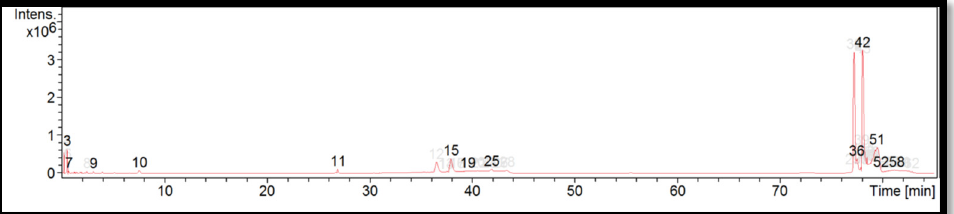
Figure 3. LC-MS/MS chromatogram of B. vulgaris . Table 7. The compounds identified in B. vulgaris .